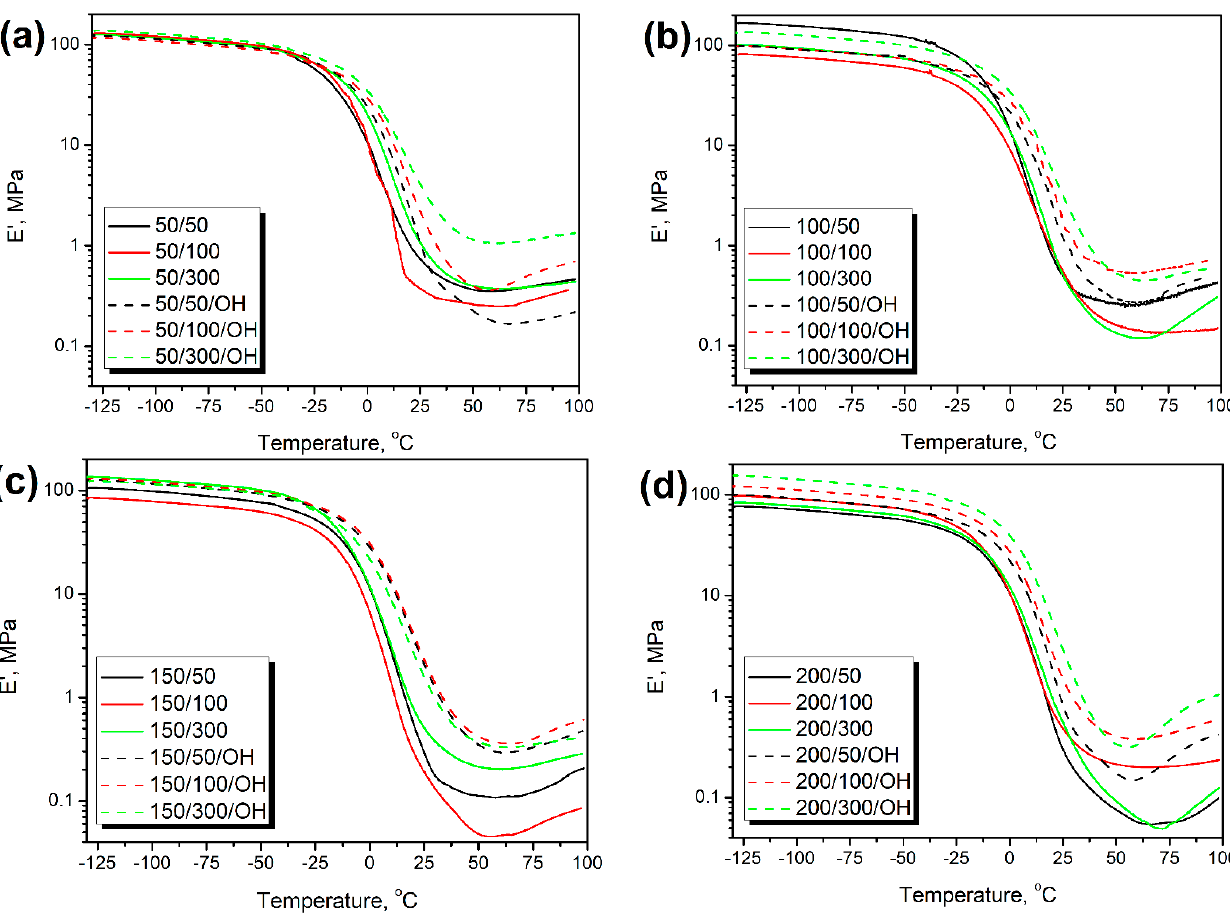
Figure 7. Temperature plots of the storage modulus for PU/GTR foams containing GTR modified at ( a ) 50 °C, ( b ) 100 °C, ( c ) 150 °C, and ( d ) 200 °C.